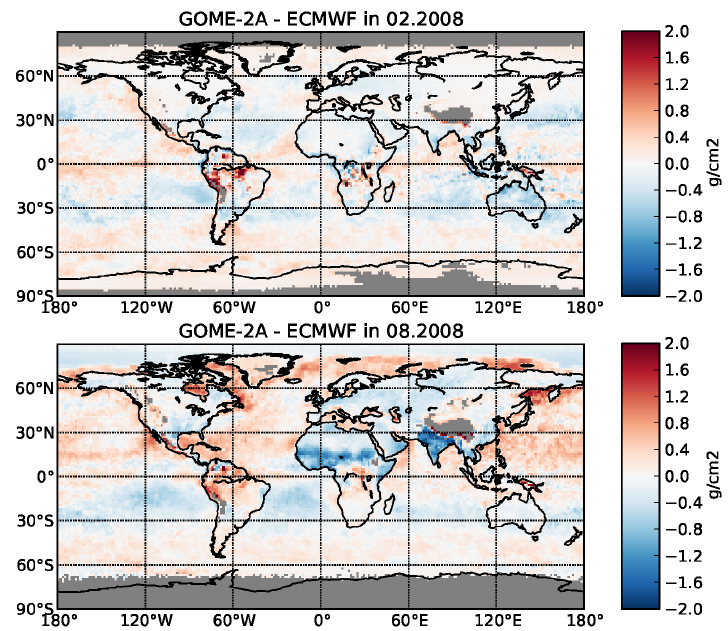
Figure 11. Geographical distribution of the differences between GOME-2A and ECMWF ERA-Interim total column water vapour in Febru- ary 2008 (top panel) and August 2008 (bottom panel). Only cloud-screened co-located data have been used.